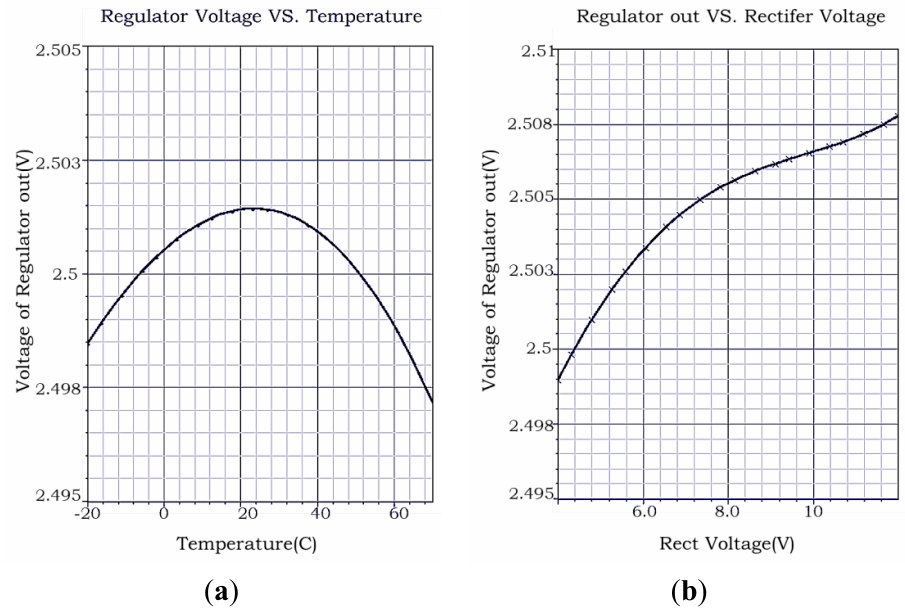
vs. Temp Simulation results of regulator V Figure 7. ( a ) V CC V Simulation results of regulator V REC0